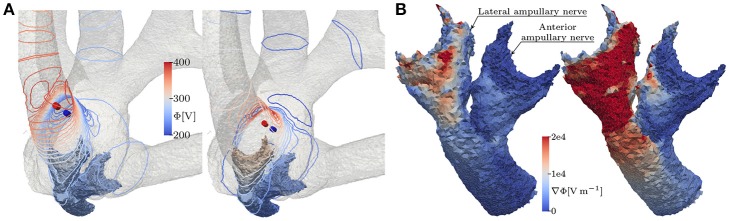
(A) Equipotential lines at the surface of the vestibular system and (B) the resulting potential gradient along anterior and lateral nerve of the topmost (left) and the deepest (right) lateral, bipolar electrode configuration, respectively. The fields are derived from the unscaled potential distribution with a current strength of 1 A from active to reference electrode (from red to blue cylinders).